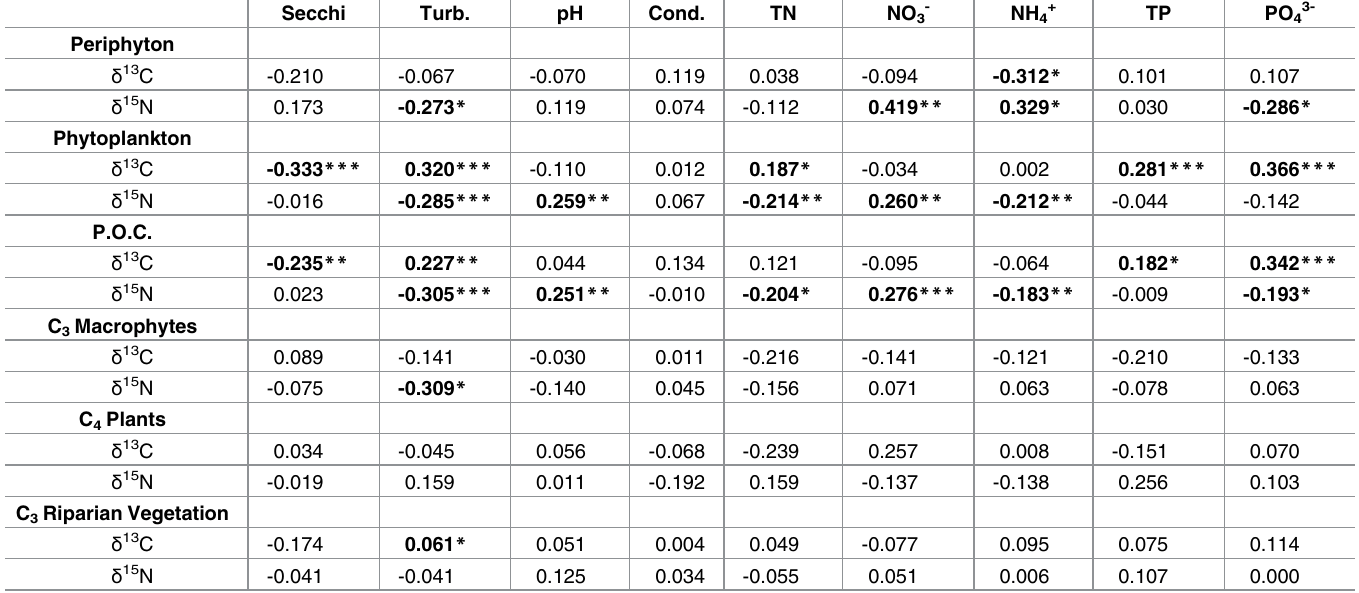
Table 3. Pearsoncorrelation coefficients between stable isotope values( δ 13 C or δ 15 N) and environmental variablesfor each source. Significantval- ues are in bold with level of significance denotedusing asterisks ( * p < 0.05; ** p < 0.01; *** p < 0.001).Turb = Turbitity, Cond = Conductivity, TN = Total Nitro- gen, TP = Total